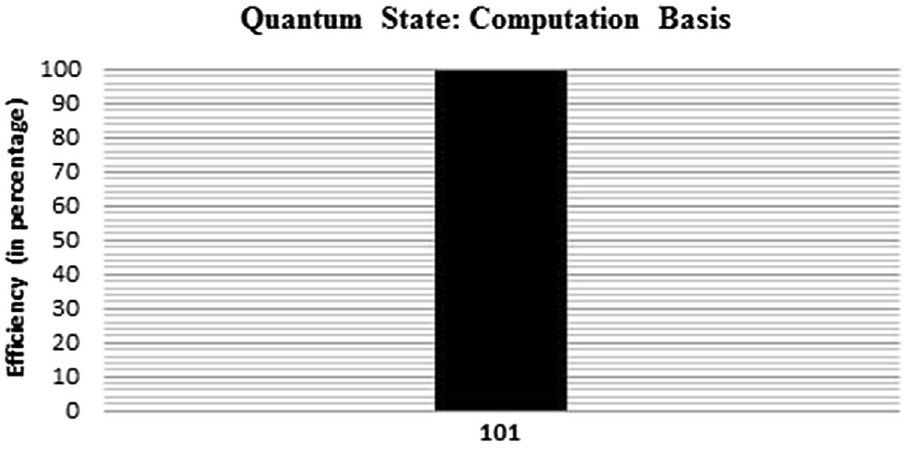
Figure 2. Simulation